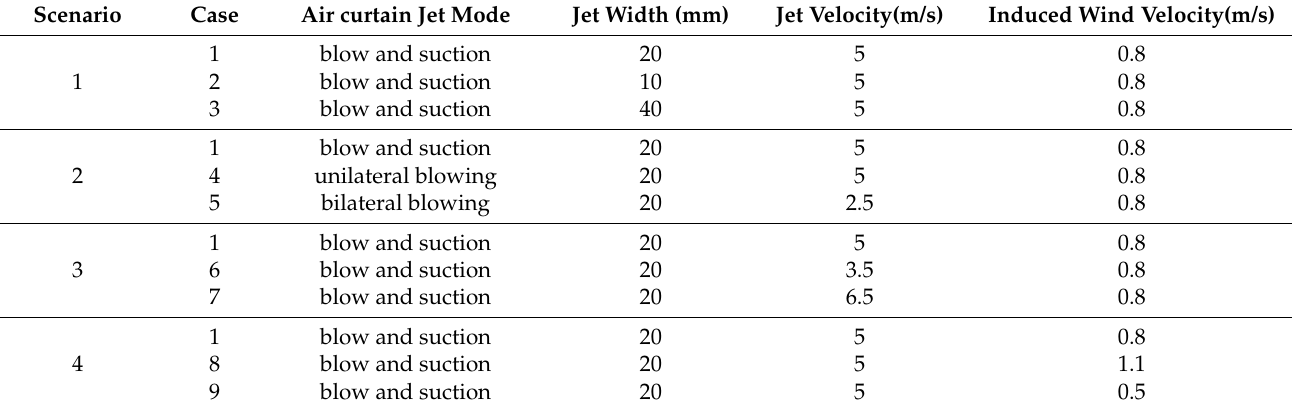
Table 3. Simulation cases under different air curtain parameters.